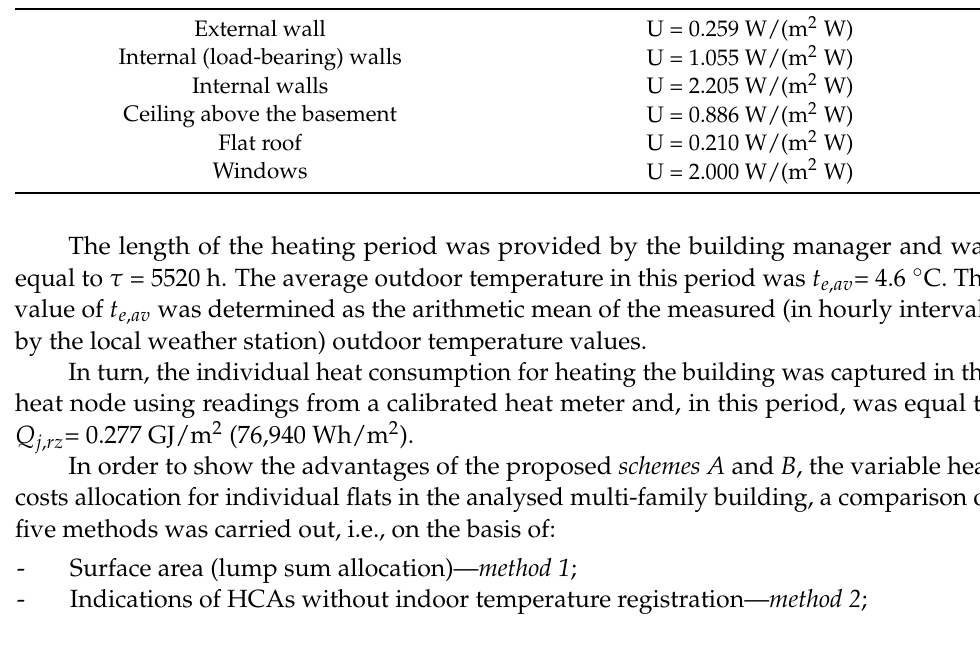
Table 1. Insulating parameters of partitions in the analysed multi-family